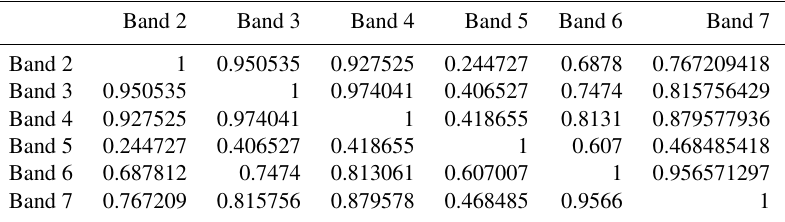
Table 1. Interband correlations.